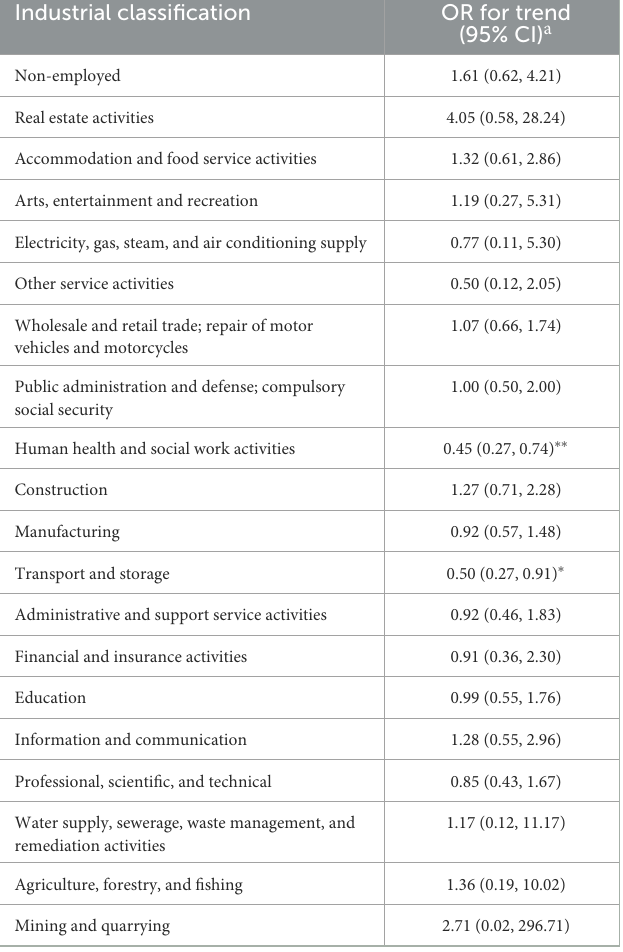
TABLE 2 Temporal trend of gender disparity of prevalence of those who screen positive for common mental health problems, from 2012–2014 to